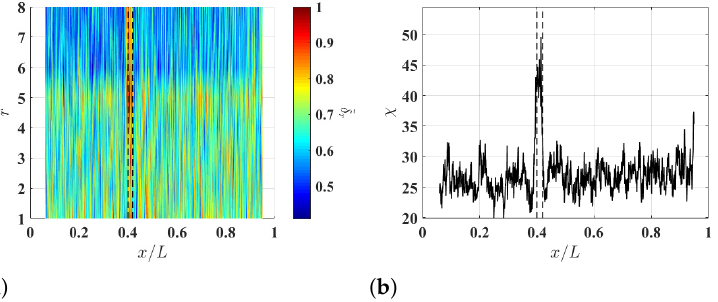
Figure 5. ( a ) Multi-resolution auxiliary TSCDI ˜ δ r associated with δ l − r , r with r = 1,2, . . . ,8 and ξ = 10% and ( b ) auxiliary CDI χ associated with ˜ δ r in ( a ). Locality and extent of the damage are indicated by two dashed lines.